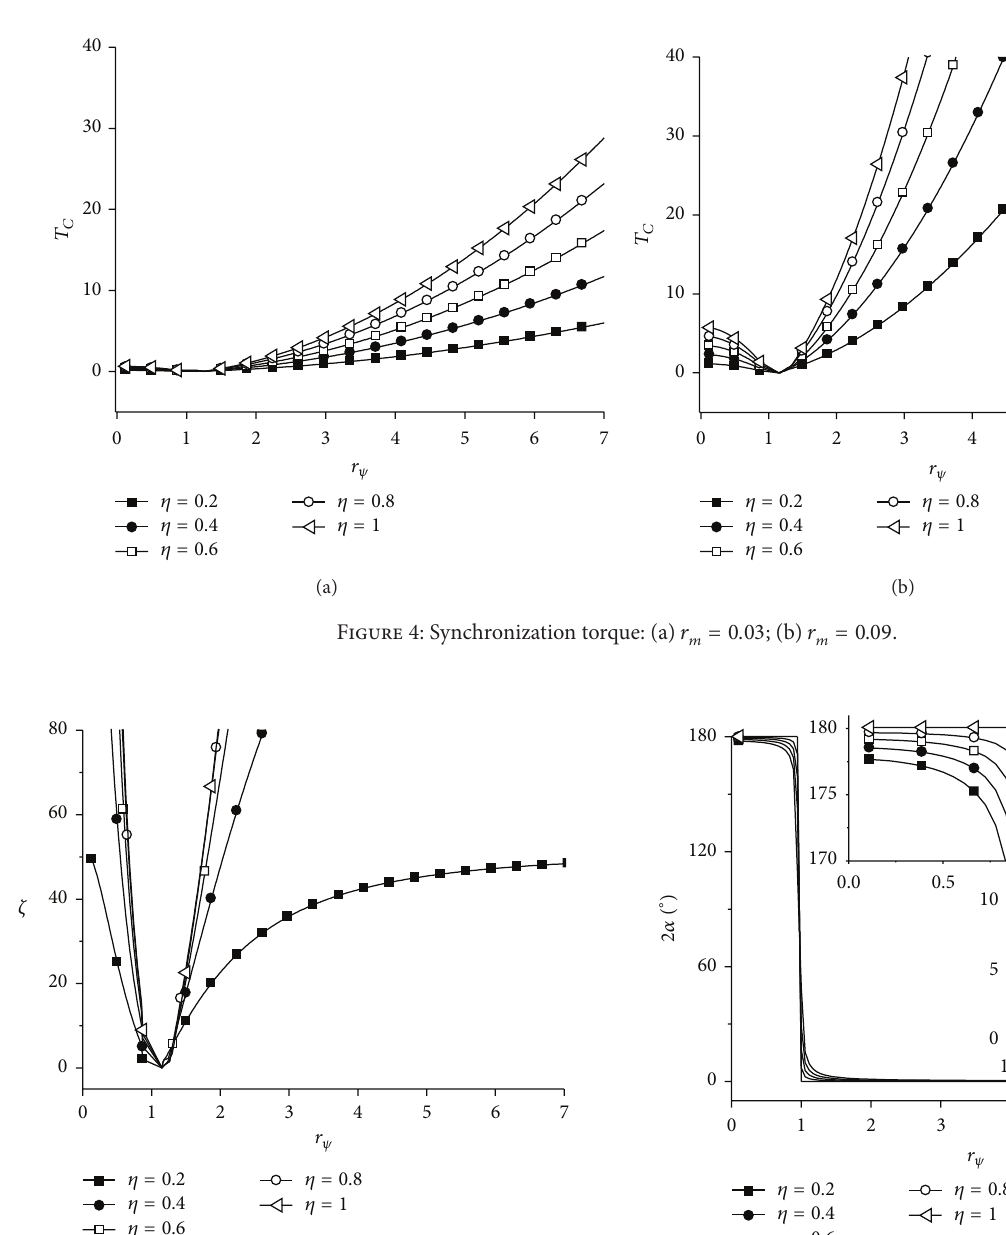
Figure 5: Coefficients of synchronization ability. Figure 6: Approximate values of 2𝛼 versus 𝑟